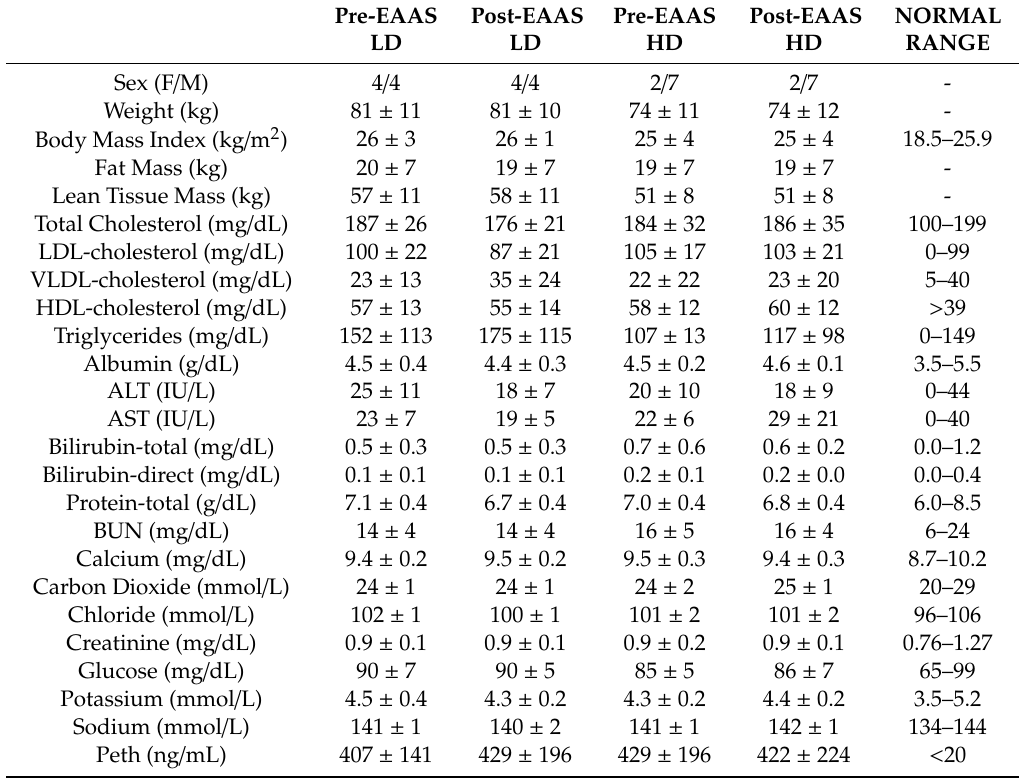
Table 2. Clinical